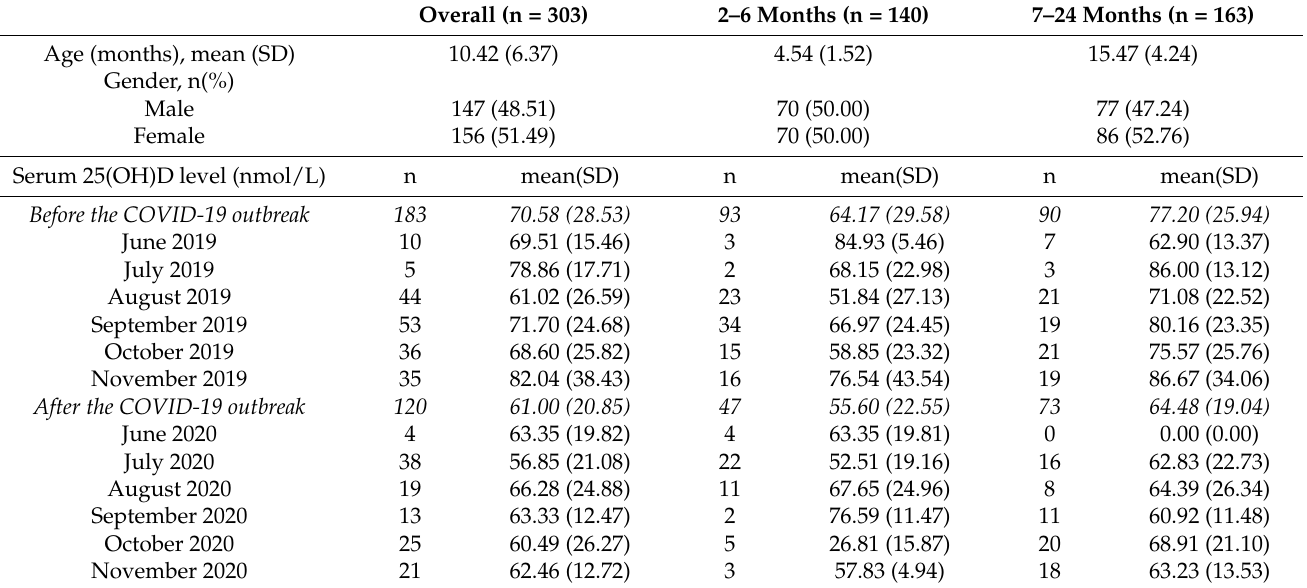
Table 1. Subject